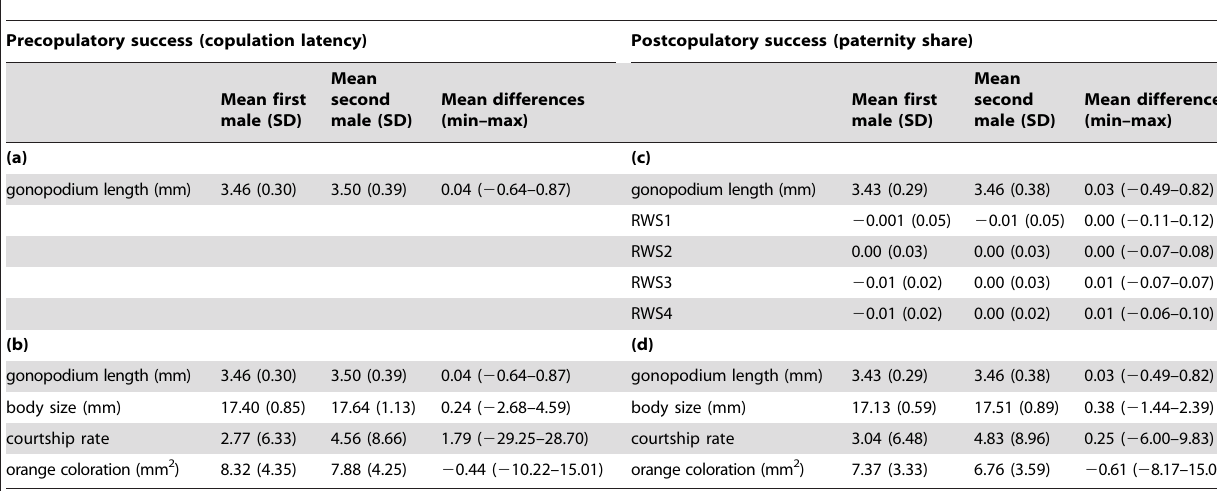
Table 1. Descriptive statistics for male traits